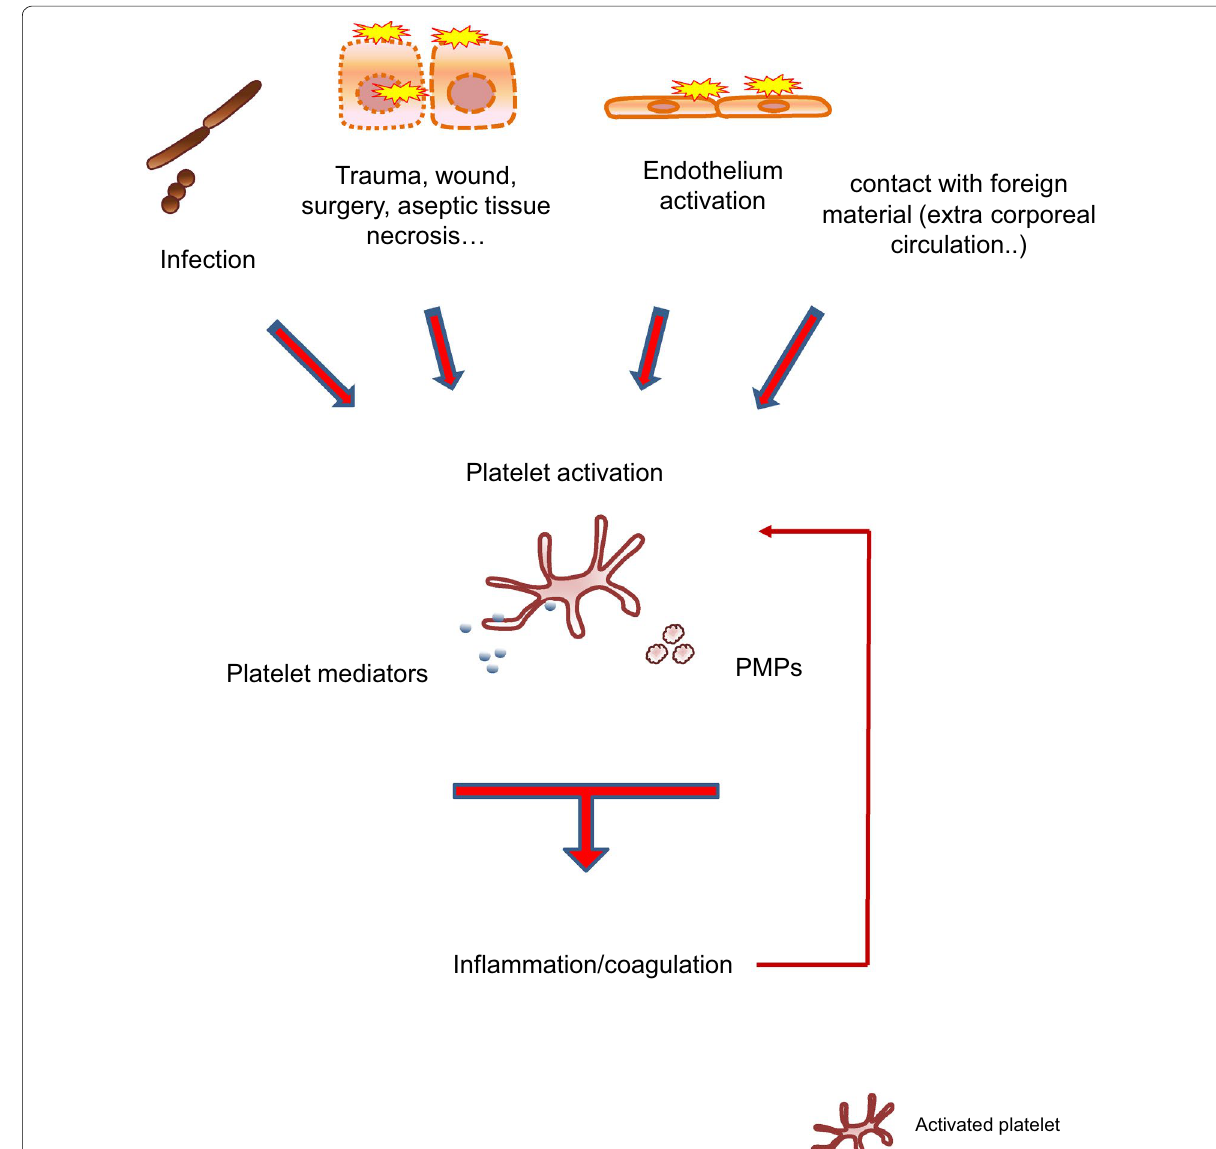
Fig. 2 Platelets monitor and are activated in response to noxious signals. Platelets sense and are activated by multiple signals generated in danger situations met by the organism. Interaction with pathogens, endothelial cell/tissue injury and interaction with foreign material activate platelets (see text for details). Platelet activation sparks off a broad range of responses, including the activation of various inflammation and coagulation pathways. Signals generated in inflammation and coagulation can in return activate platelets (thin arrow). PMPs platelet